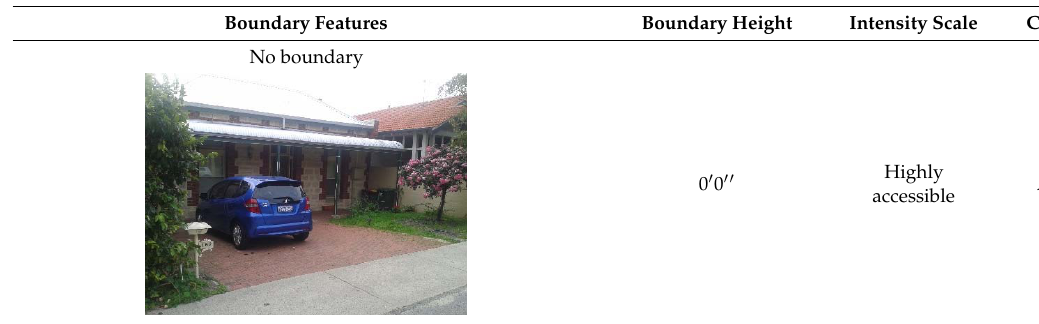
Table 2. Types of physical accessibility.